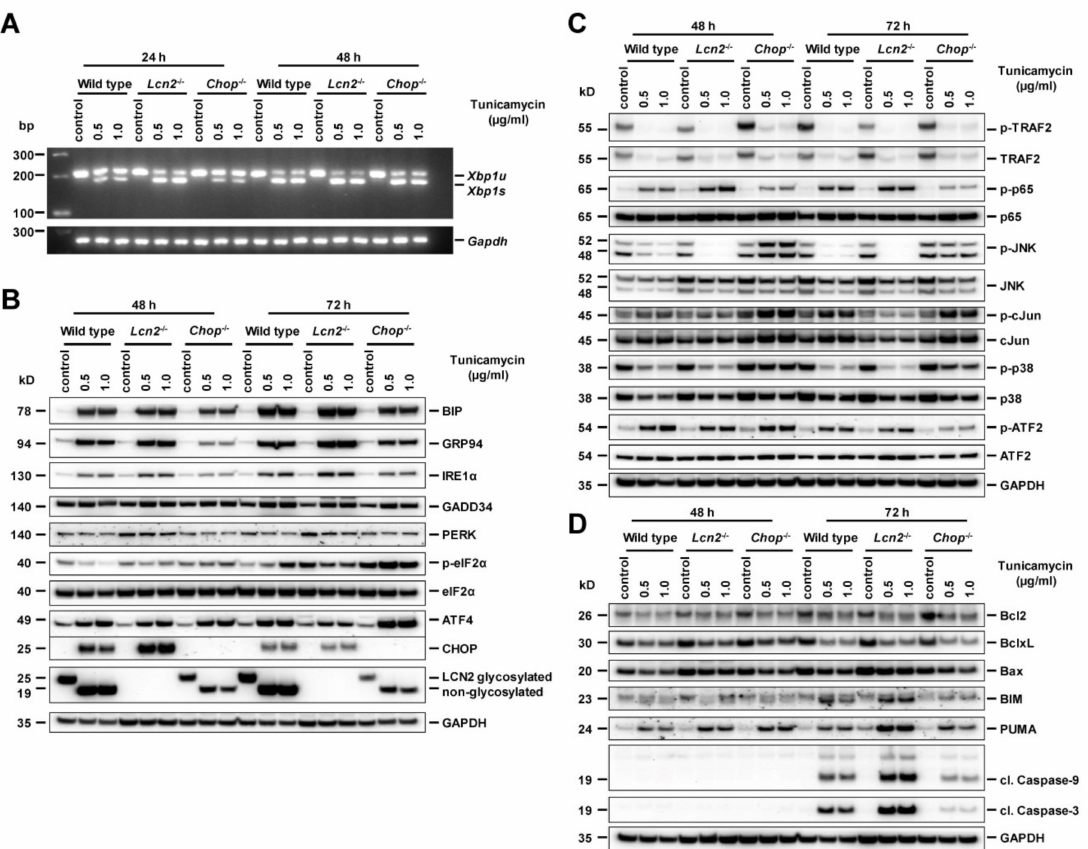
Figure5. Tunicamycinincubationfor48and72hdidinducehepatocyteapoptosis. ( A )Semi-quantitative PCR showing unspliced ( Xbp1u ) and spliced Xbp1 ( Xbp1s ) mRNA after 24 and 48 h tunicamycin (TM) ( B ) Western blots of UPR signaling proteins BiP, GRP94, IRE1 α , ATF6, PERK, p-eIF2 α , eIF2 α ,